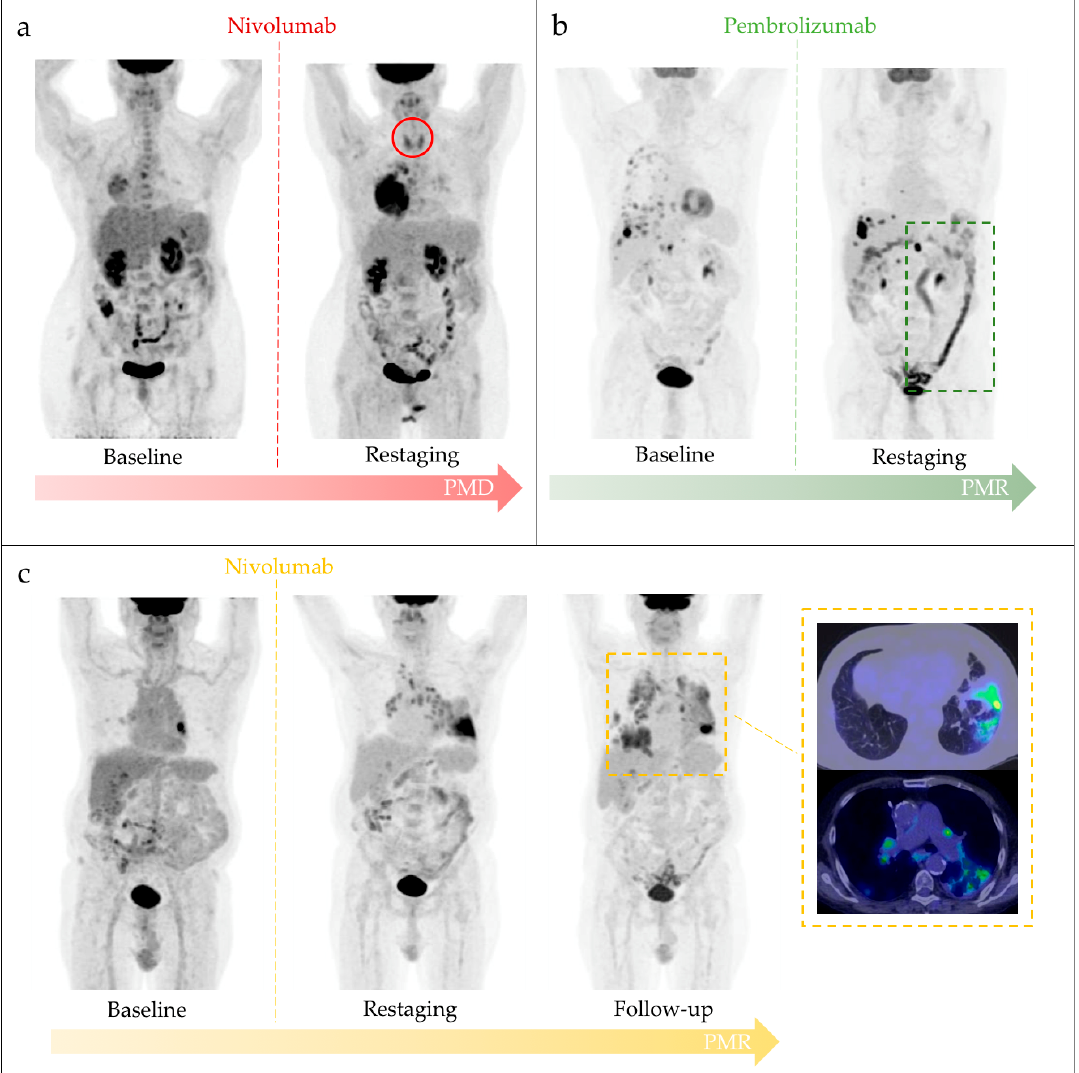
Figure 3. Most representative cases of irAEs detected on [ 18 F]FDG PET/CT in our sample. ( a ) Immunotherapy-related thyroiditis: 58yo female with advanced lung adenocarcinoma under nivolumab immunotherapy. After 8 cycles of therapy, asymptomatic thyroiditis was incidentally found on restaging PET/CT (red circle). The same scan showed progressive metabolic disease (PMD), confirmed by follow-up. ( b ) Immune-related colitis: 64yo man affected by stage IV NSCLC, with pleural involvement and lymph nodes metastasis detected on basal PET/CT. During pembrolizumab treatment, the patient reported persistent diarrhea. Restaging PET/CT scan showed partial metabolic response (PMR) and increased [ 18 F]FDG uptake in the colon region consistent with immune-mediated colitis (green dotted square). ( c ) Immune-related pneumonitis and sarcoid-like reaction: 56yo man with stage IIIA NSCLC who received nivolumab monotherapy as first line treatment. Basal PET/CT showed [ 18 F]FDG uptake both in the left pulmonary lesion and hilar bilateral lymphadenopathies. First restaging [ 18 F]FDG PET/CT showed increase in bilateral mediastinal and hilar lymphadenopathy involvement and diffuse lung parenchymal uptake, suggesting a sarcoid-like reaction together with a pneumonitis (yellow dotted square), the latter supported by the presence of dyspnea and dry cough. Nivolumab was continued and subsequent PET/CT scan showed a partial metabolic response